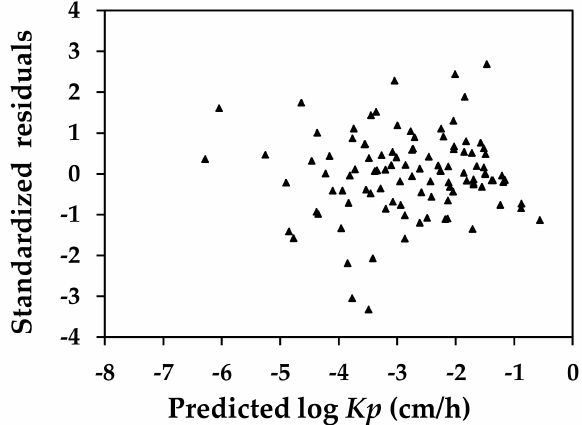
Figure 2. Scatter plot of standardized residuals versus logarithmic values of skin permeation coefficient ( Kp ) predicted using Kp quantitative structure-activity relationship (predicted log Kp ) developed in this study for compounds included in in training and validation